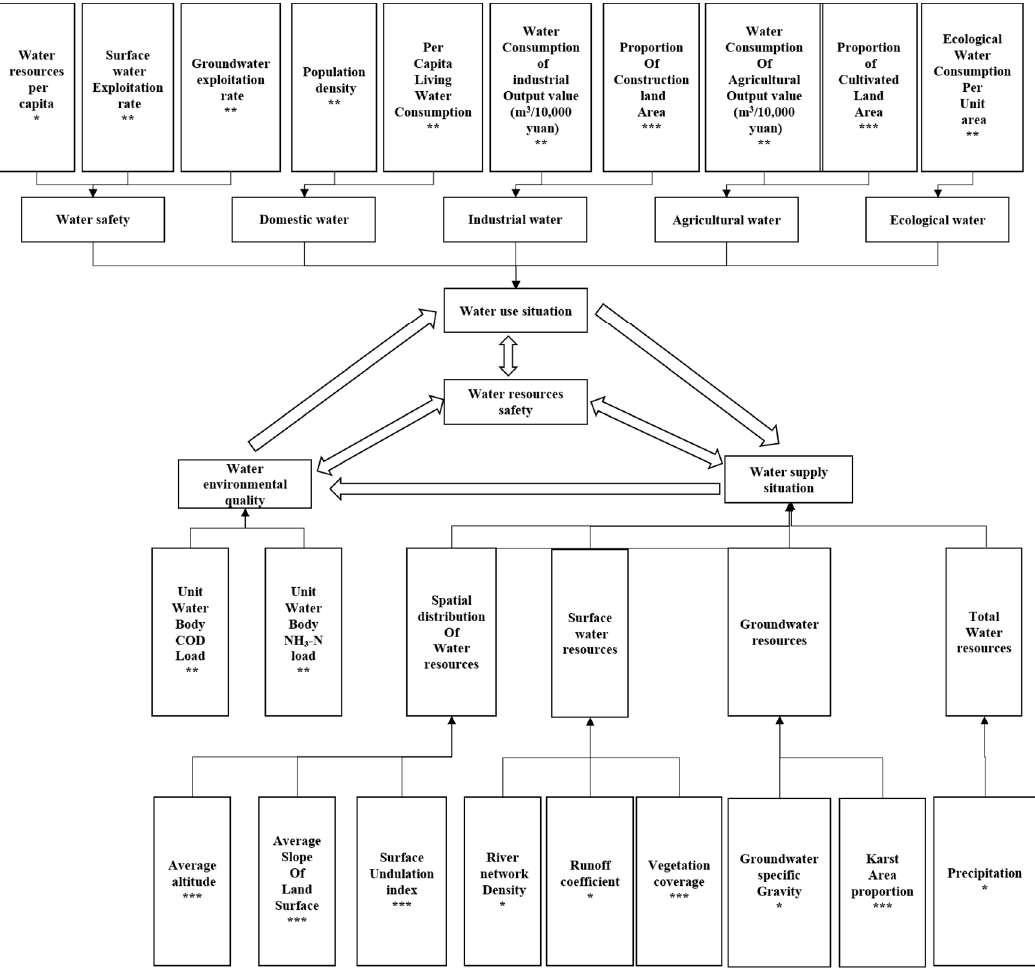
Figure 1. Water resources security “man-land-water” conceptual model framework. * Represents water resources background conditions. ** Represents human activity intensity. *** Represents geological and geomorphological features. The arrows indicate the direction of